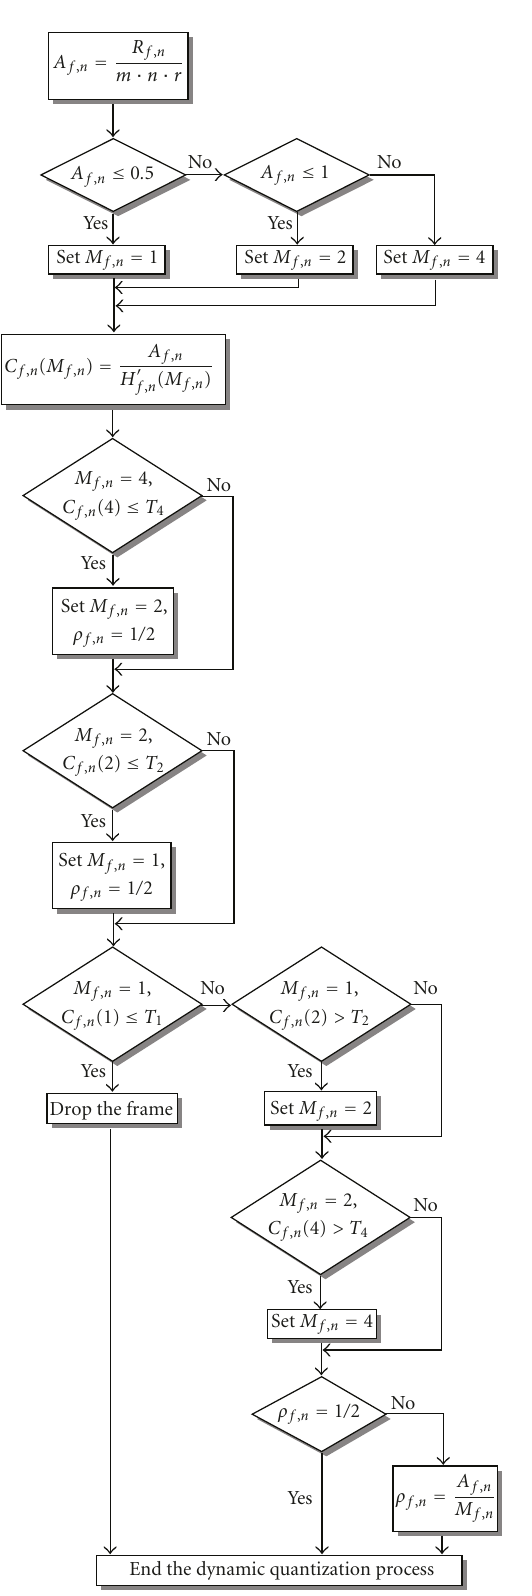
Figure 4: Dynamic quantization algorithm with a frame dropping mechanism.